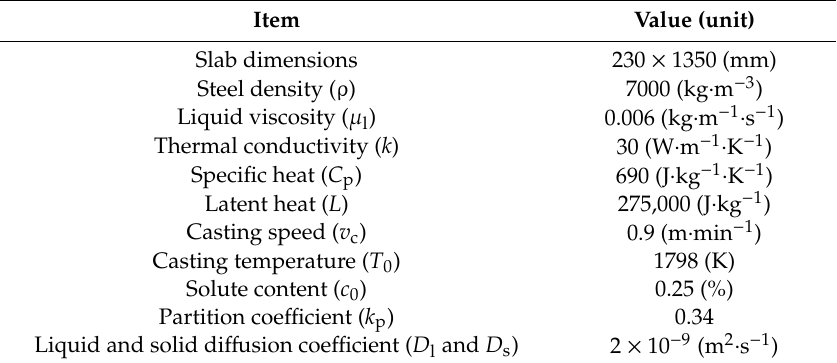
Table 1. Physical properties and process parameters used in the numerical simulation.